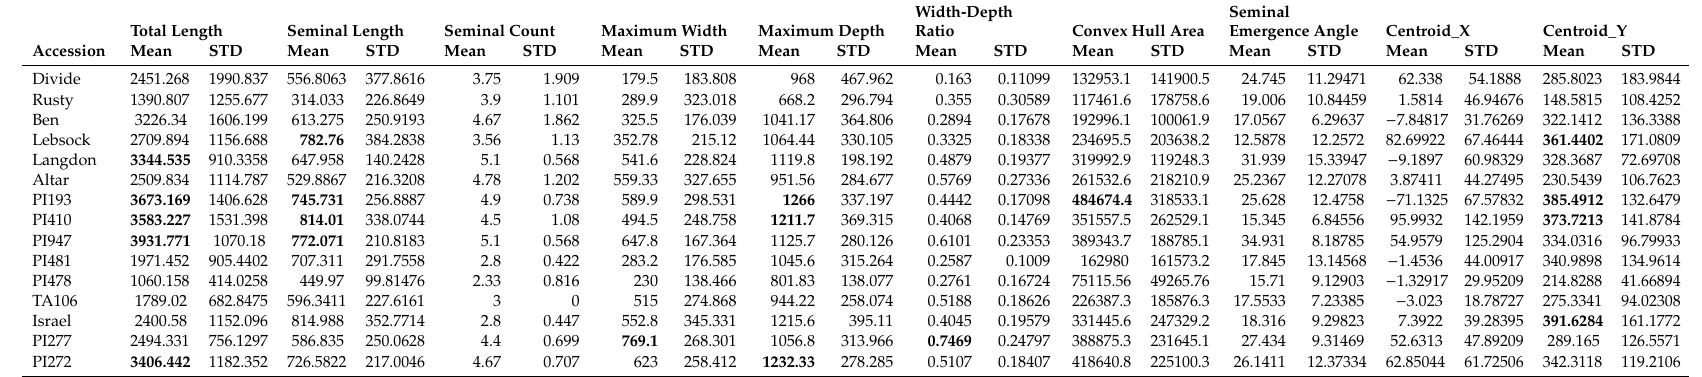
Table 3. Root system architecture traits measured in 15 wheat accessions (tetraploid). The bolded mean values showed level of significance at p < 0.05 compared to the reference accession (Rusty). Each trait has a column representing the mean value of 10 replicates for each accession followed by their standard